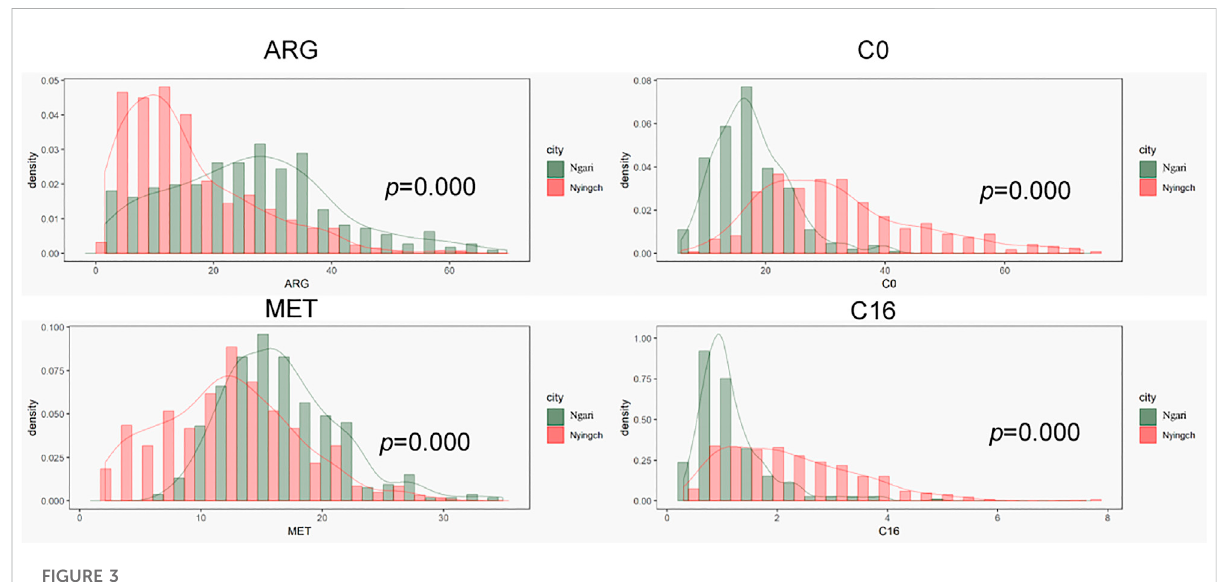
FIGURE 3 Comparison of metabolite index between Ngari and